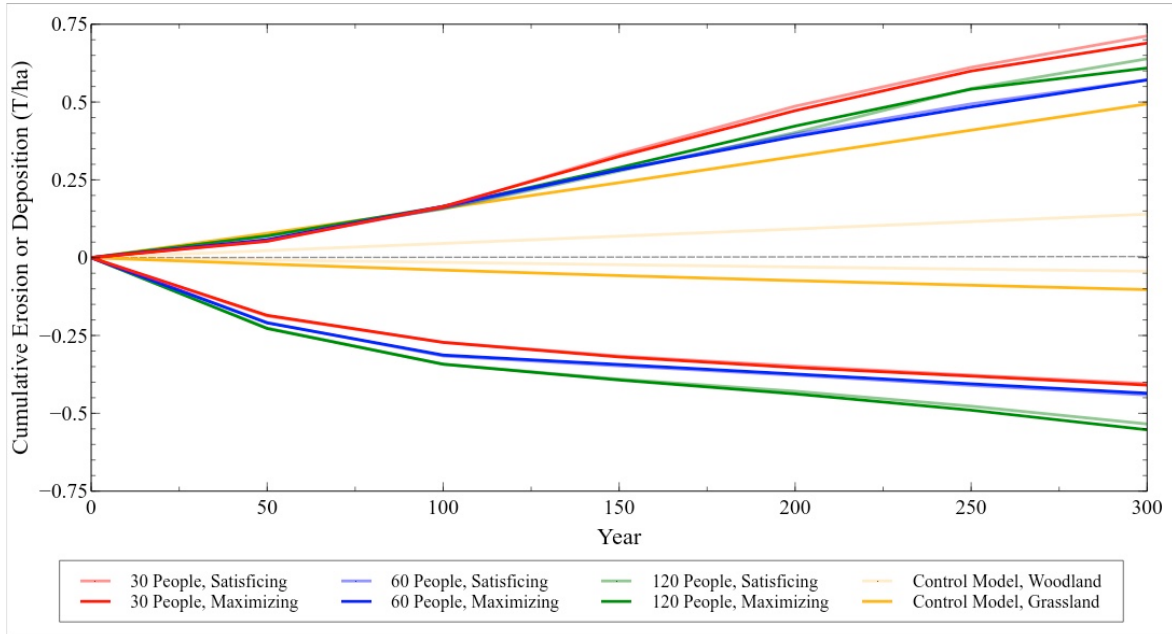
Figure 12. Cumulative amount of sediment eroded or deposited (tons/ha) in the Mas d’Is Barranco for each of the six experiments and two control runs during the 300-year modeling interval. Values are averaged across the 40 repetitions of each experiment. The cumulative tons/ha of eroded sediment are shown below the center lines of each graph, and cumulative tons/ha of deposited sediment are above the center lines for the 300 year modeling interval. We show erosion and deposition separately because sediment removal and accumulations often happen in different landscape contexts, with different consequences for agropastoral and other